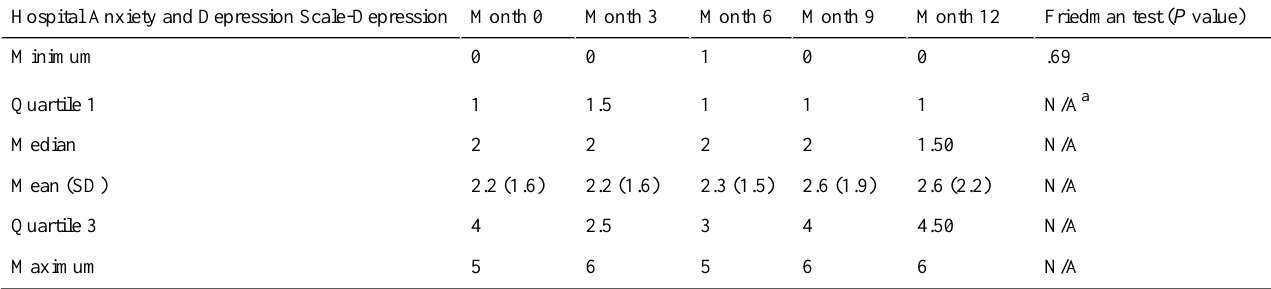
Table 12. Informal caregivers’anxiety and depression scores during the year observation period.